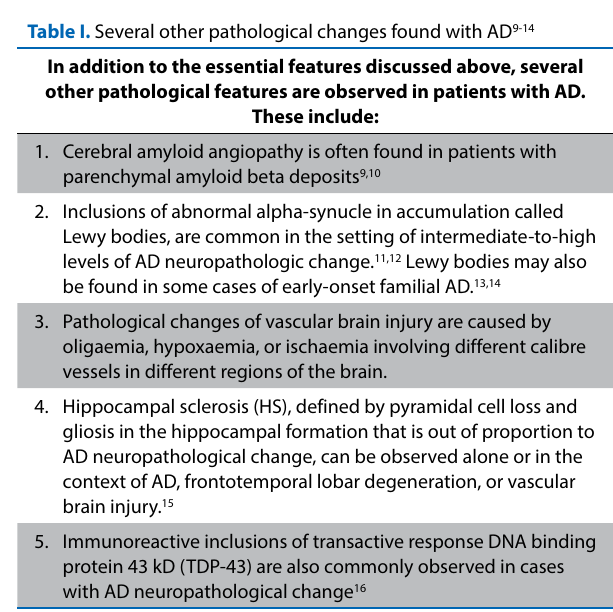
Table I. Several other pathological changes found with AD